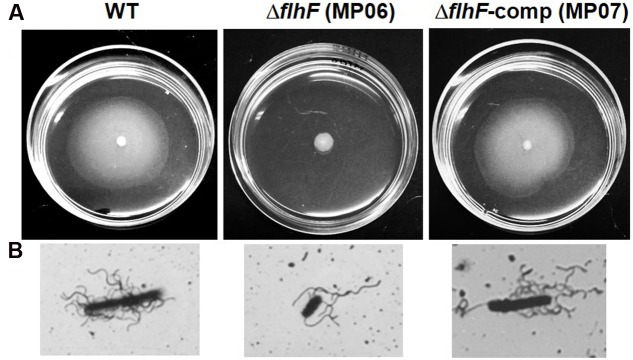
Analysis of swarming motility.
(A) Colonies produced on swarming TrA plates. (B) Representative cells obtained from swarming TrA plates and stained with tannic acid and silver nitrate.